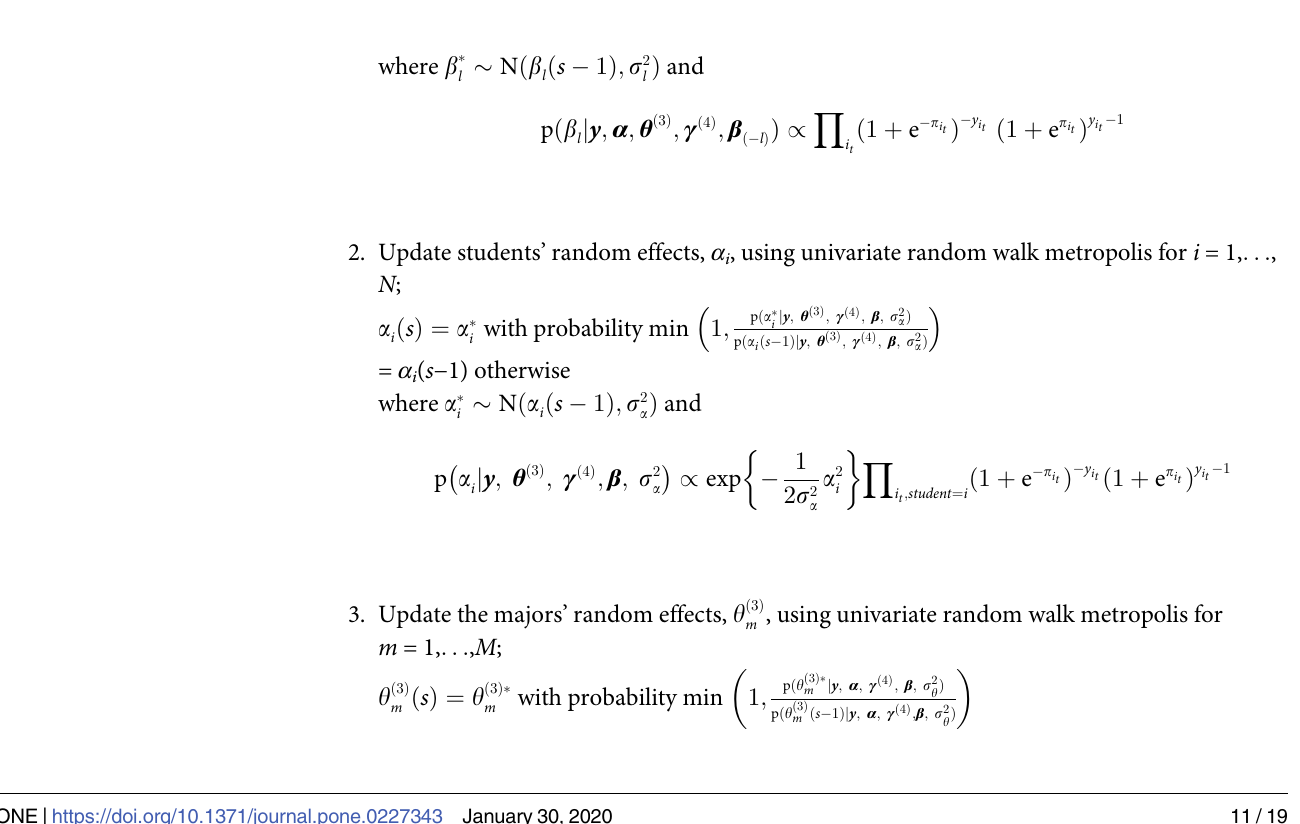
Fig 3. Markov Chains and posterior distributions for variance components when modeling probability of getting GPA 3.0 or better.